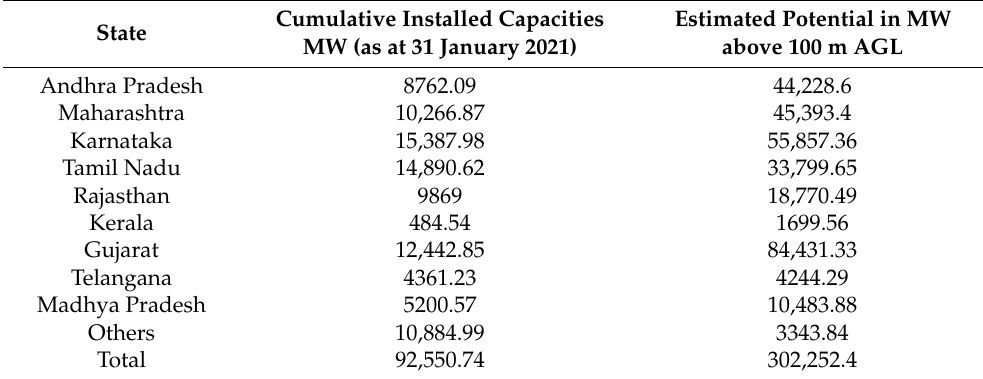
Table 16. Comparison of cumulative installed capacities and estimated potential in (MW), by state. Source: Indian Wind Energy Association [60] (as on 31 January.2021).